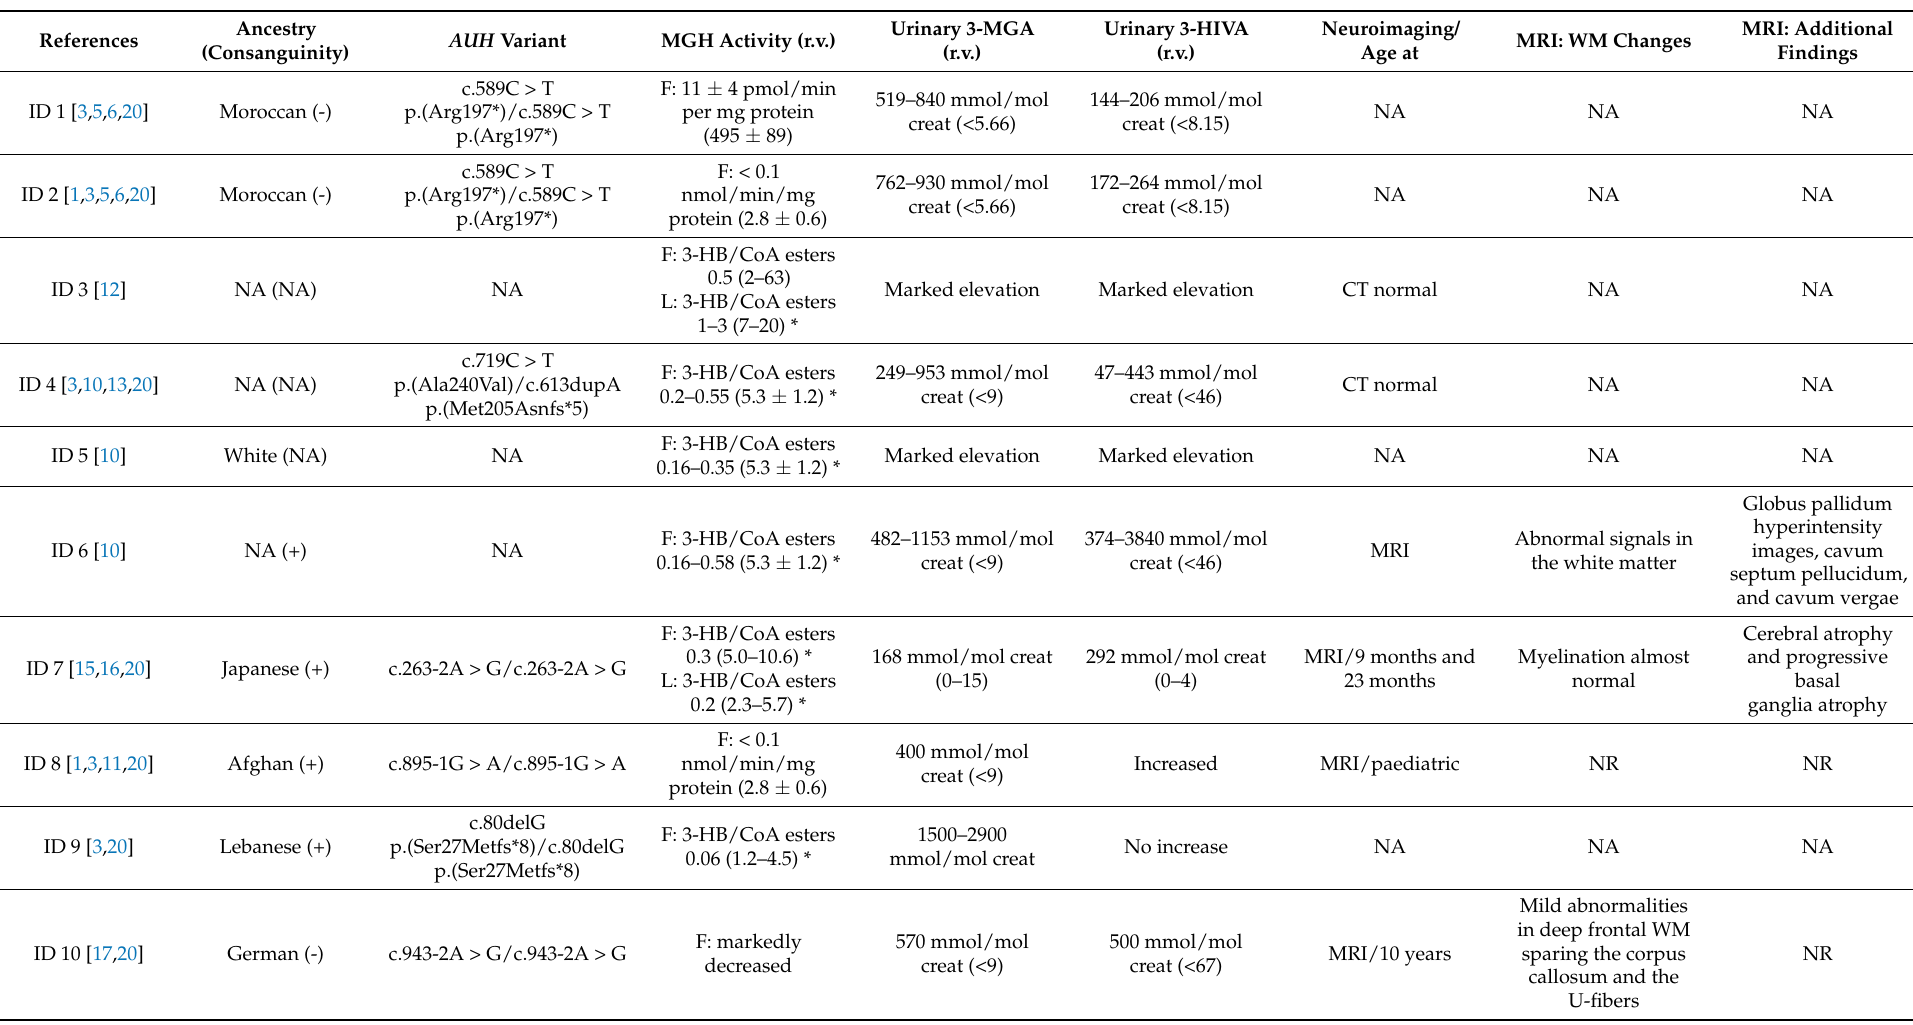
Table 1. Genetic, biochemical, and instrumental data on all AUH -deficient patients reported in the